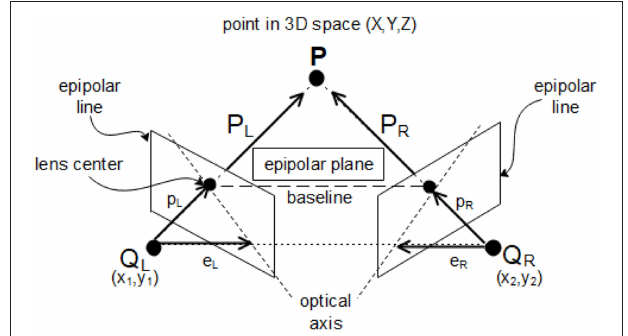
FIGURE 1 | Epipolar geometry and triangulation